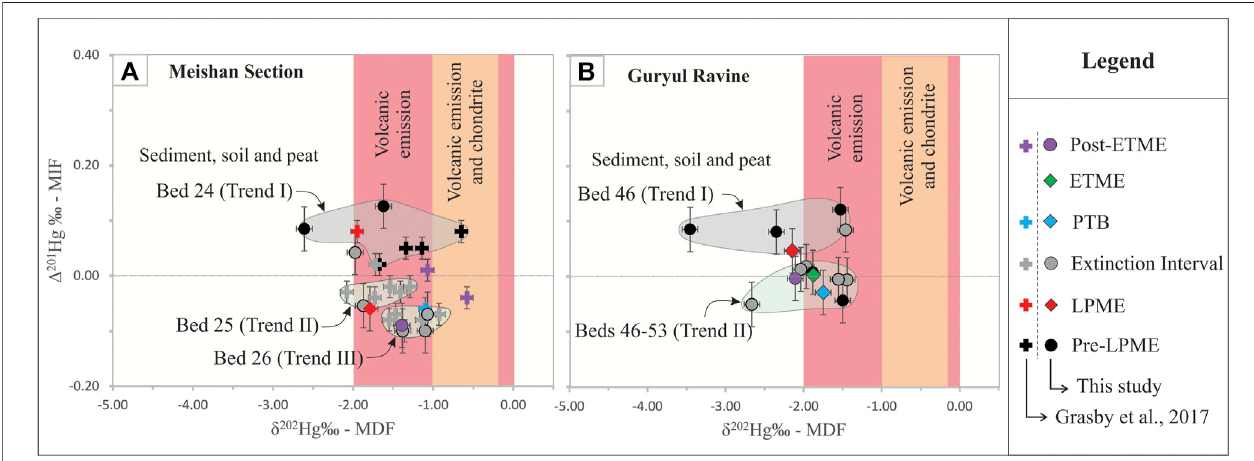
FIGURE 8 | (A) The Δ 199 Hg ‰ (MIF) vs. (B) Hg (ng.g − 1 ) crossplot for the two studied sections. See text for explanation.